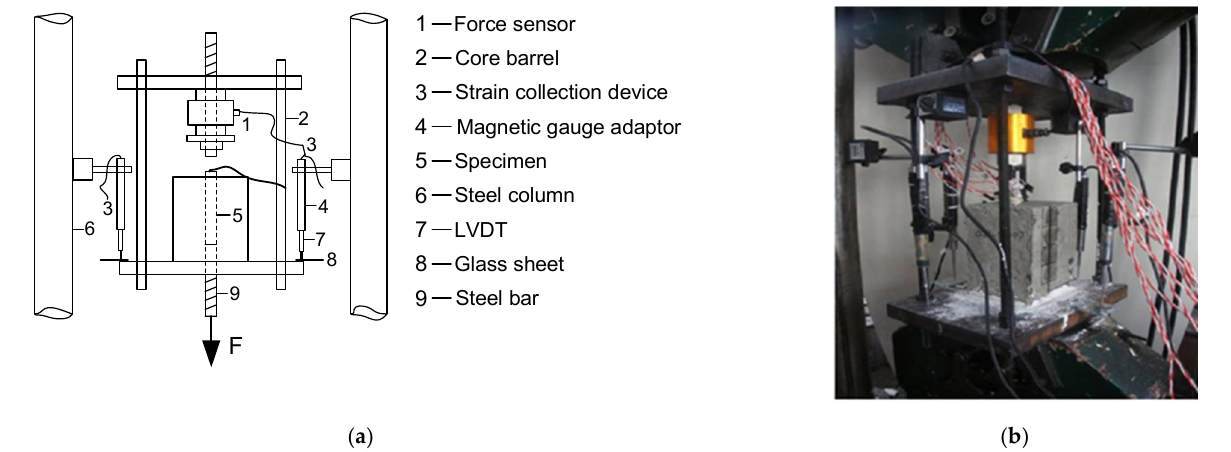
Figure 7. Test loading system: ( a ) The schematic view of loading apparatus Adapted with permission from [29]; ( b ) The loading test in site.